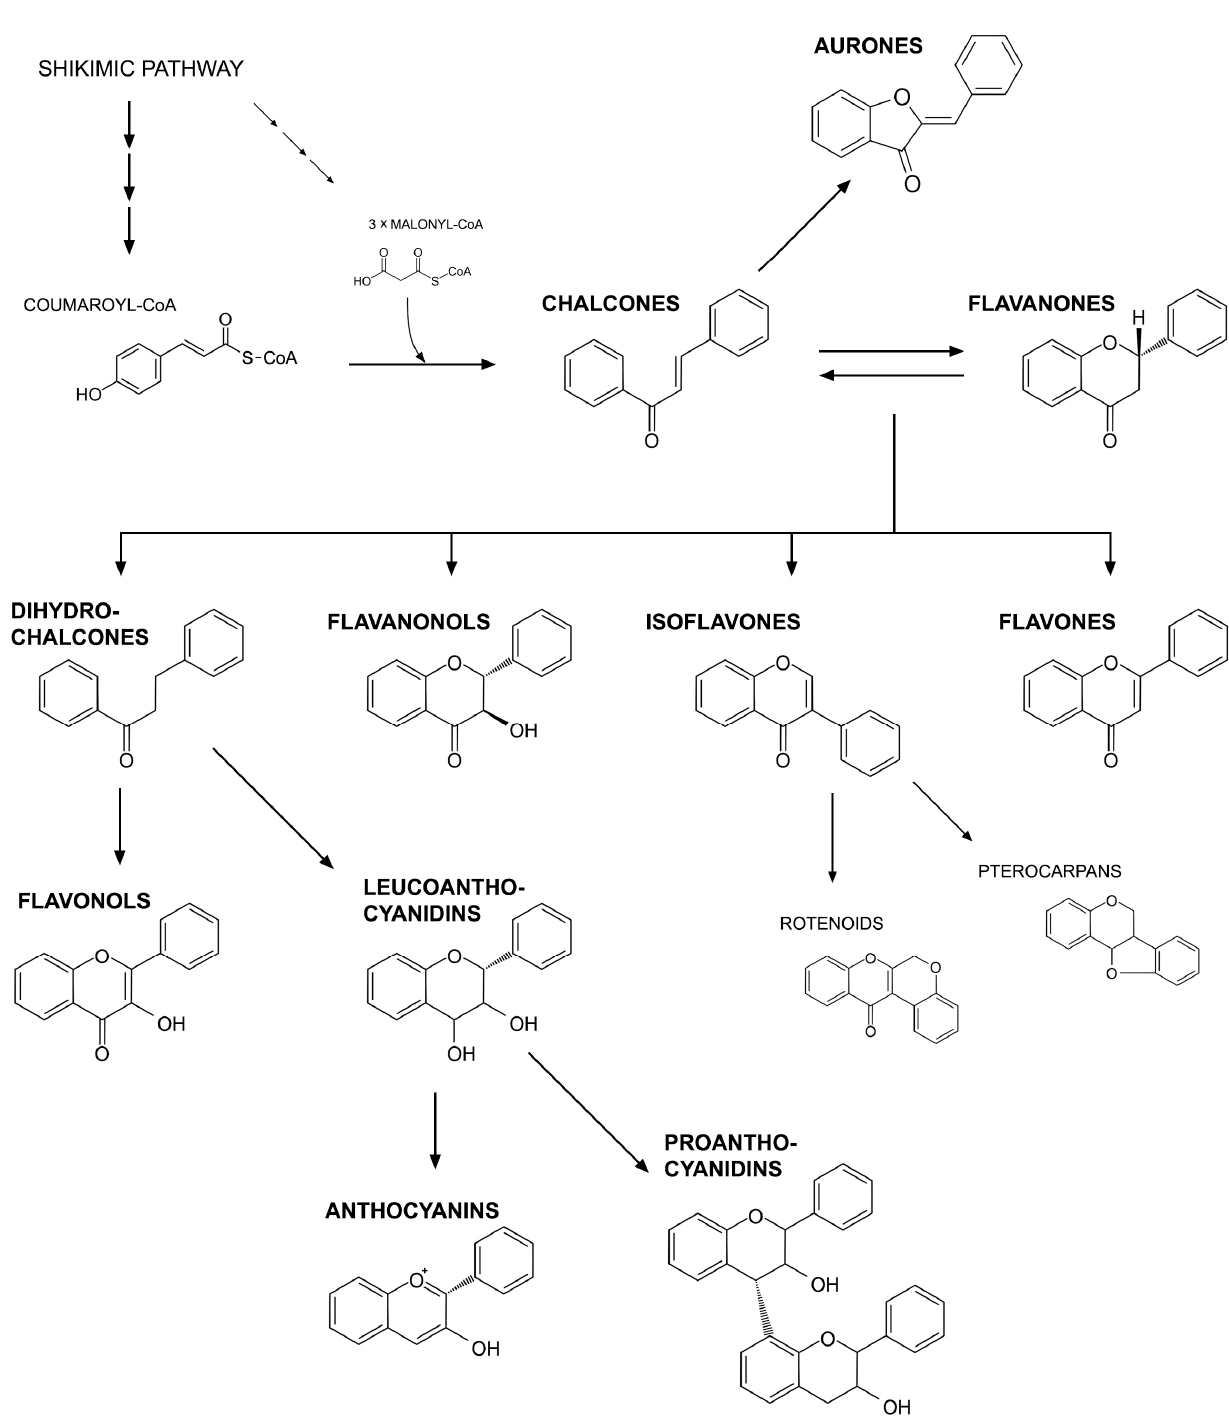
Figure 1. Classification of